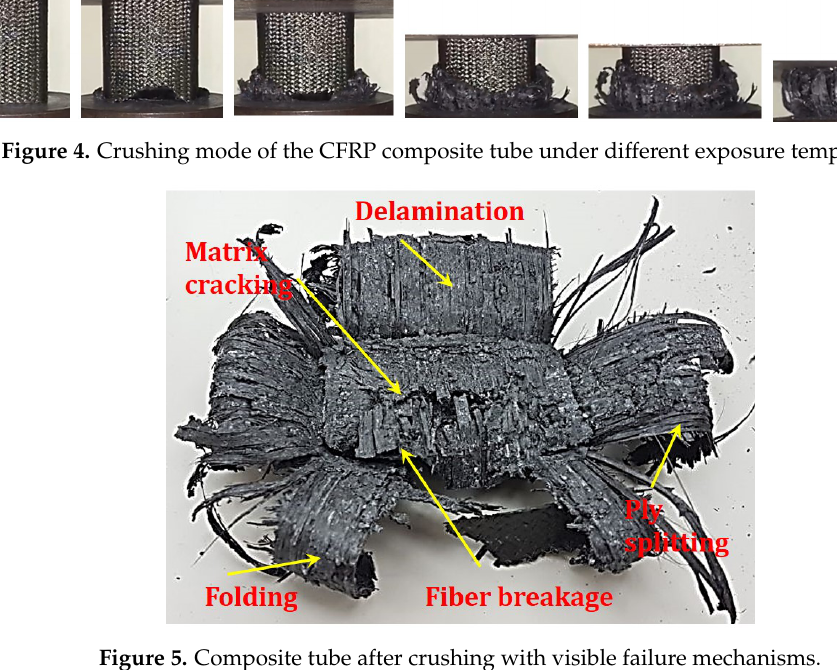
Figure 5. Composite tube after crushing with visible failure